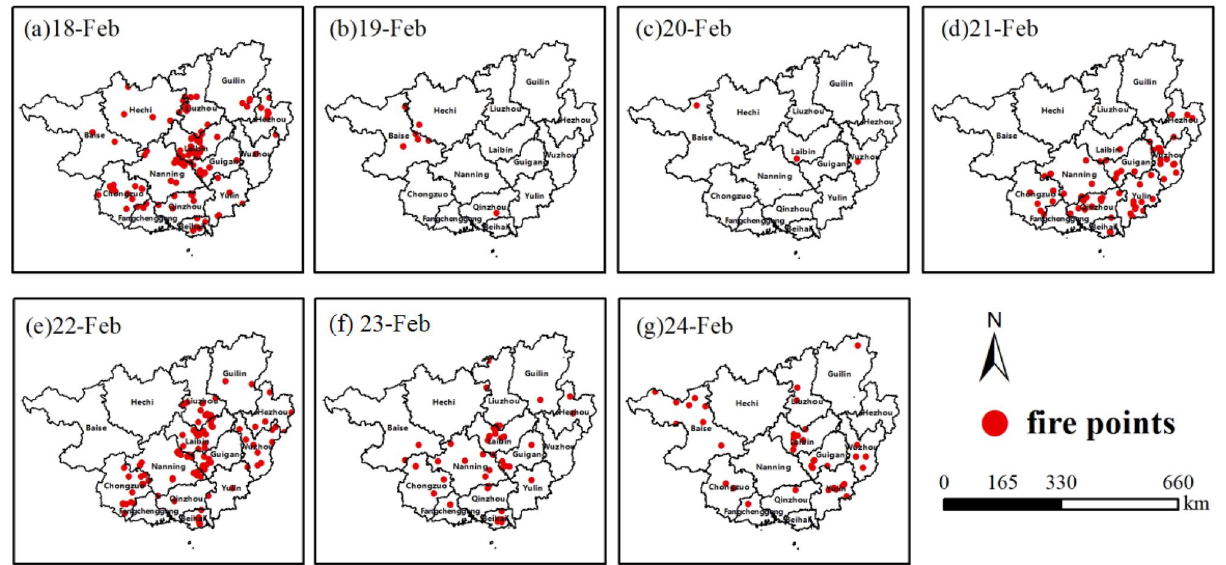
Figure 3. Distribution of fire spots in Guangxi from February 18 to 24, 2020. The map was generated using ArcGIS Desktop 10.3, https:// deskt op. arcgis. com/ en. (Data source of fire spots: Satellite-monitored fire spots (Aqua, Himawari-8, NOAA20, NPP and Terra).